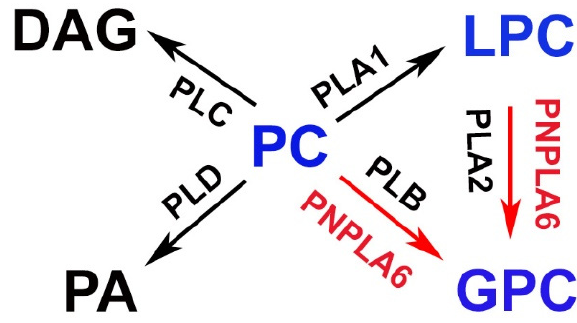
Figure 3. Proposed functions of PNPLA6/NTE in lipid metabolism. PNPLA6/NTE shows activity in hydrolyzing phosphatidylcholine (PC) or lysophosphatidylcholin (LPC) to glycerophosphocholine (GPC). DAG = diacylglycerol, PA = phosphatidic acid, PLA1 = Phospholipase A1, PLA2 = Phospholipase A2, PLB = Phospholipase B, PLC = Phospholipase C, PLD = Phospholipase D.